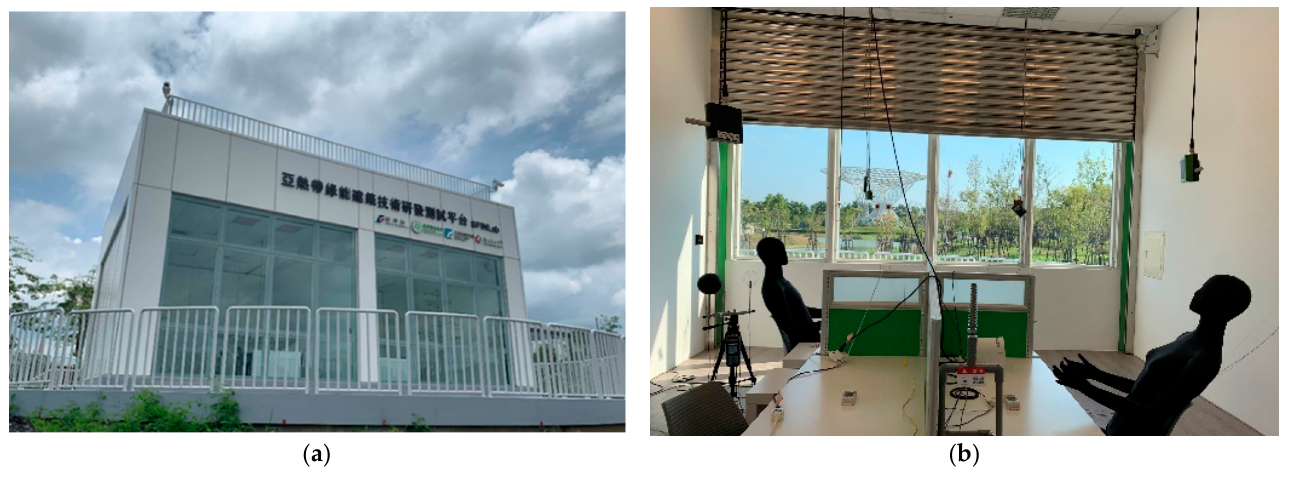
Figure 3. The intermittent control scheme of TPC for central systems and packaged systems (trans- lated) [18].